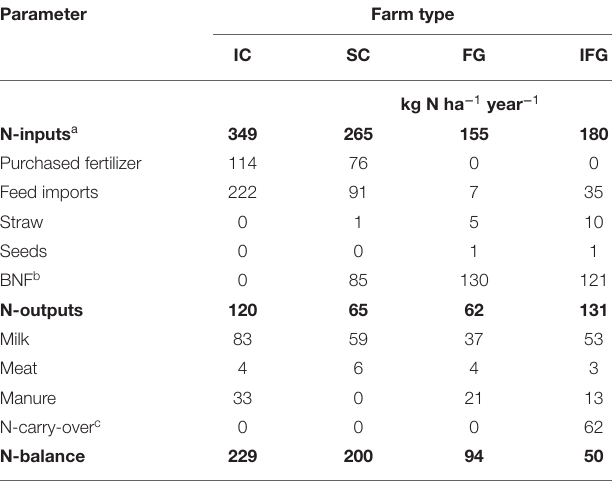
TABLE 3 | Global warming potential (GWP) per ha in the different dairy systems and system units expressed in kg CO 2 -equivalents (CO 2 eq) per ha. Parameter Farm type